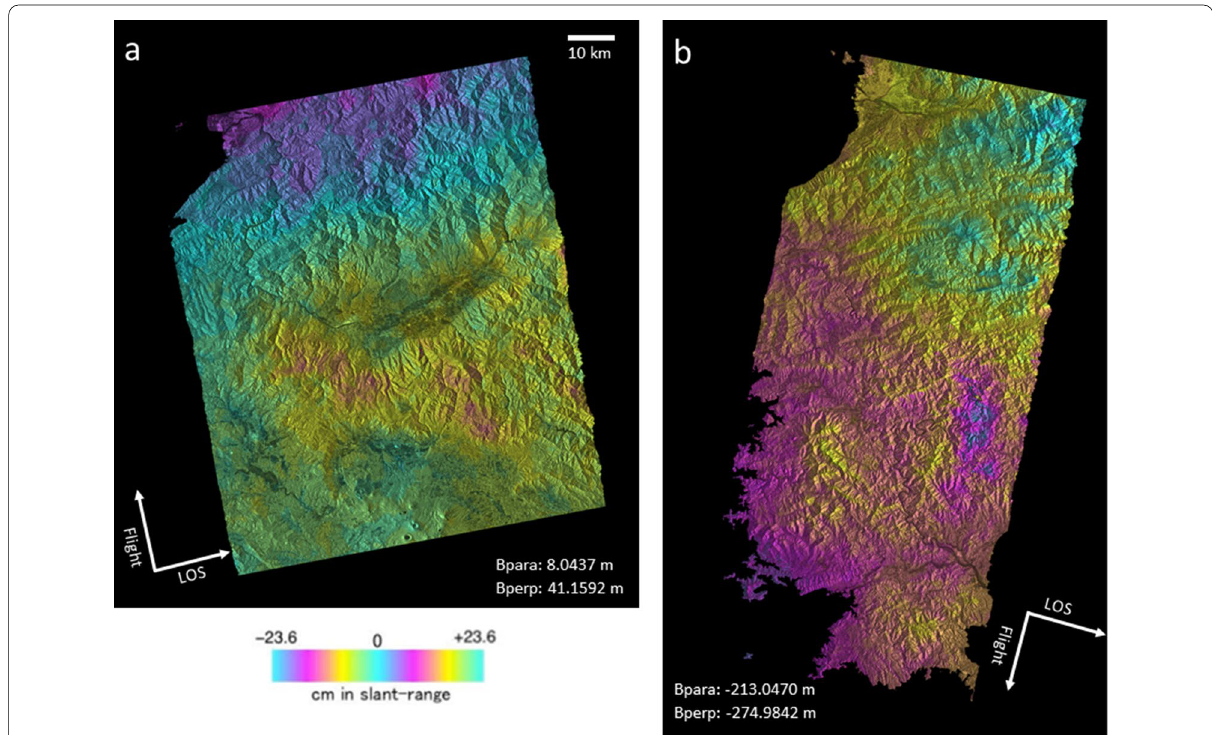
Fig. 2 Original bandwidth differential interferogram of heavy rain pairs. a Kyushu on 20180731_20180828 and b Shikoku 20180815_20181107